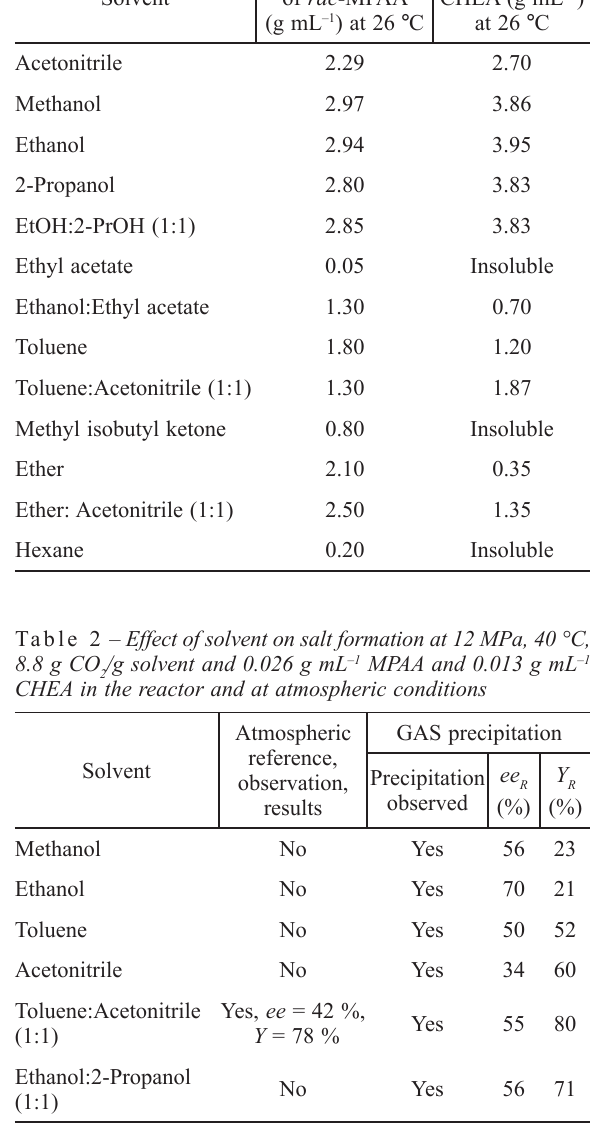
(Figure 3). XRD patterns of the ( S,S ) - salt and ( S,R ) - salt are different which proves that the two salts are crystallized in different crystalline structures. Com-